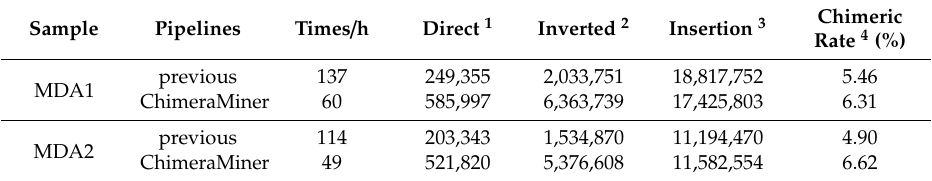
Table 1. The statistics of the two chimera detection methods.